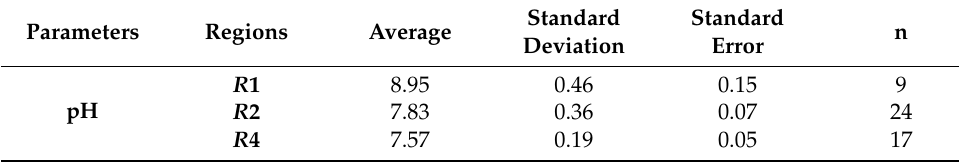
Table A5. Water qualities measured in each